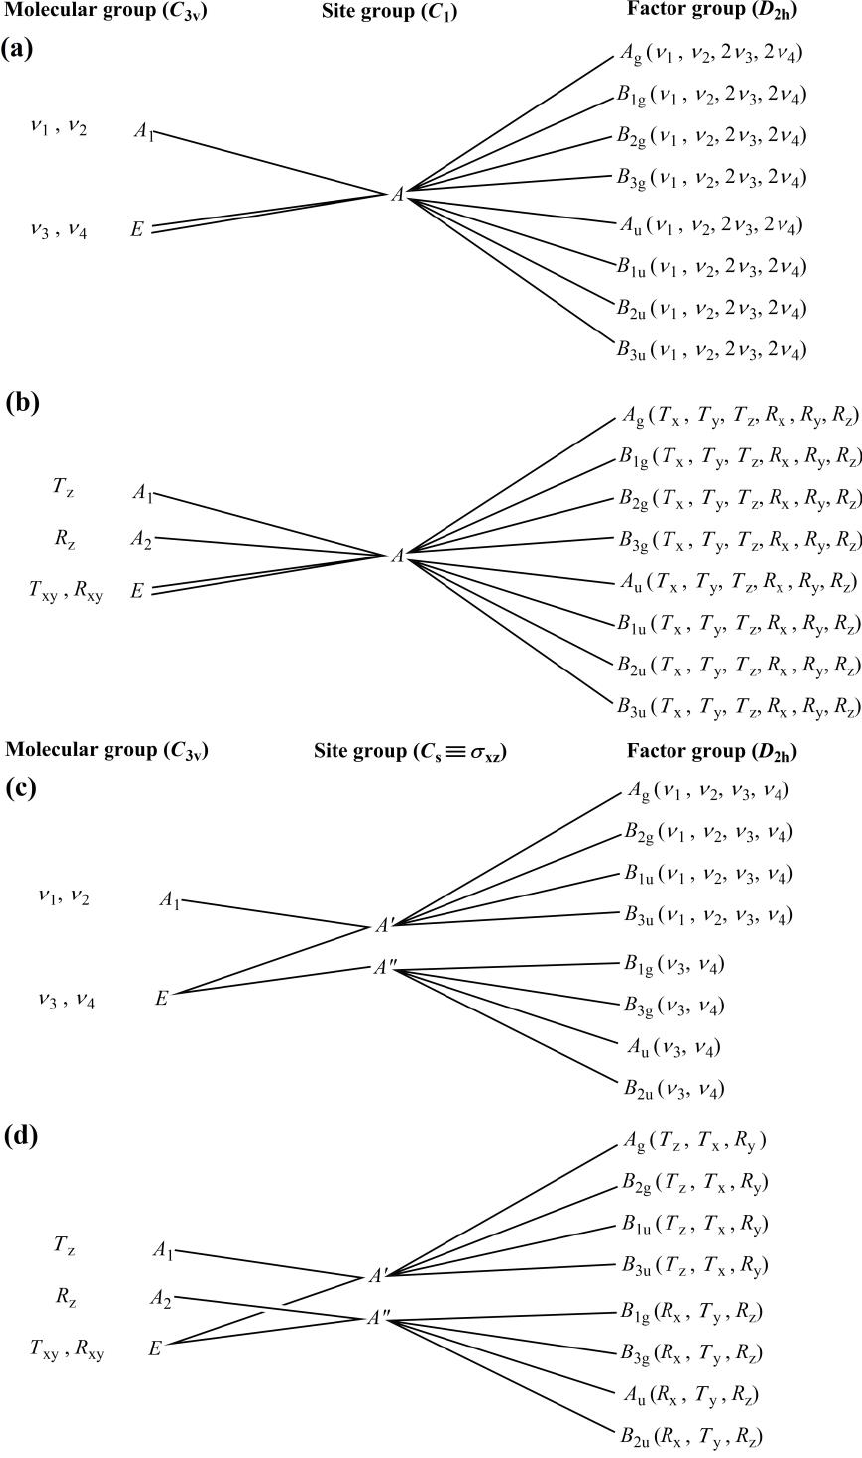
Figure 3. Factor group analysis of ( a , c ) internal, and ( b , d ) external, modes of ammonia molecules in [Co(NH 3 ) 4 CO 3 ]I. One kind of the three crystallographic types of ammonia molecules is on positions of trivial symmetry (type I , C 1 )l ( a , b ), whereas the other two crystallographic kinds of ammonia molecules are on xz planes of symmetry (type II , ( a , c )). For the ammonia molecules of type I , 4 × 6 = 24 IR and 4 × 6 = 24 Raman active internal modes were expected in every species (A u , B 1u , B 2u , B 3u and A g , B 1g , B 2g , B 3g , respectively, 2